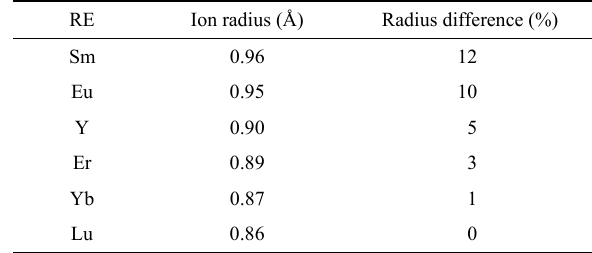
Ion radius and radius difference of the selecting REs for the design of HE RE 3 TaO 7 , RE 3 NbO 7 , and RE 3 (Nb 1/2 Ta 1/2 )O 7 (the data are obtained from the database of Materials studio program. © Accelrys Inc., San Diego, USA,